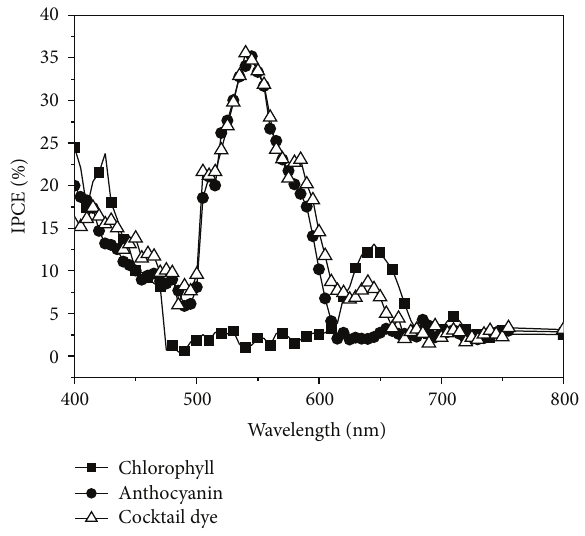
Figure 10: IPCE curves of DSSCs sensitized by chlorophyll, antho- cyanin, and cocktail